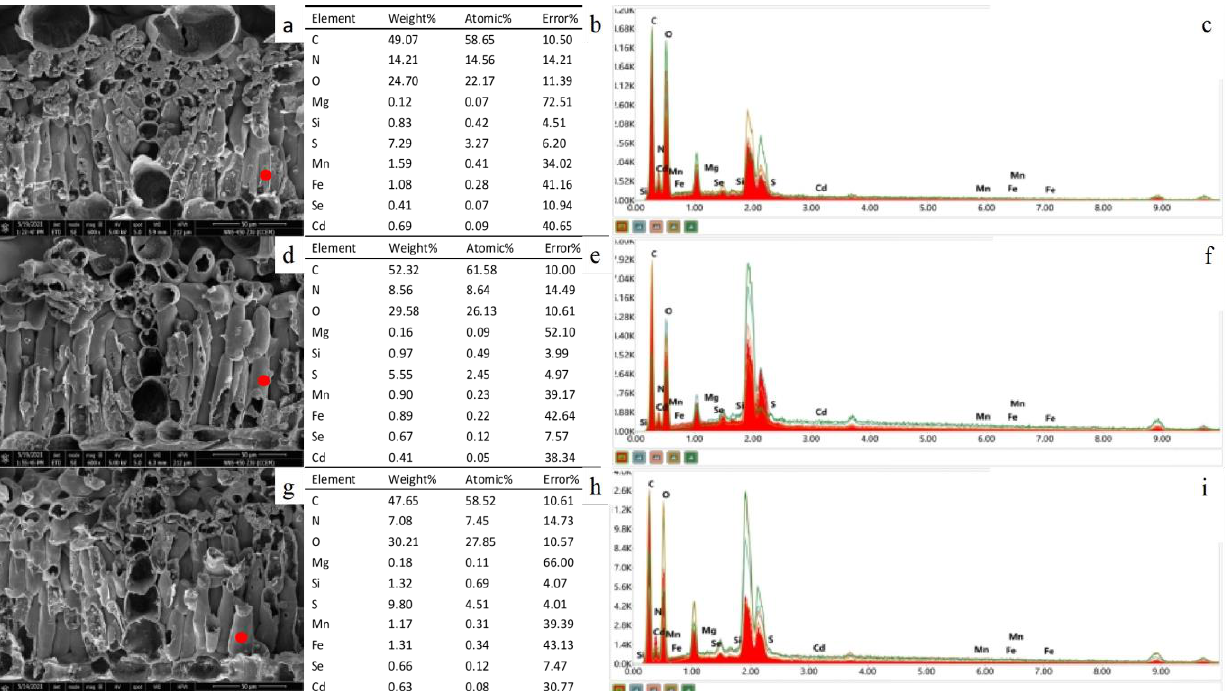
Figure 3. Scanning electron microscope images and energy spectrum analysis of leaves of Huayu 23 under blank ( a – c ), single leaf selenium ( d – f ), and single soil selenium treatments ( g – i ). The red dots in the figure represent the selection points for energy spectrum